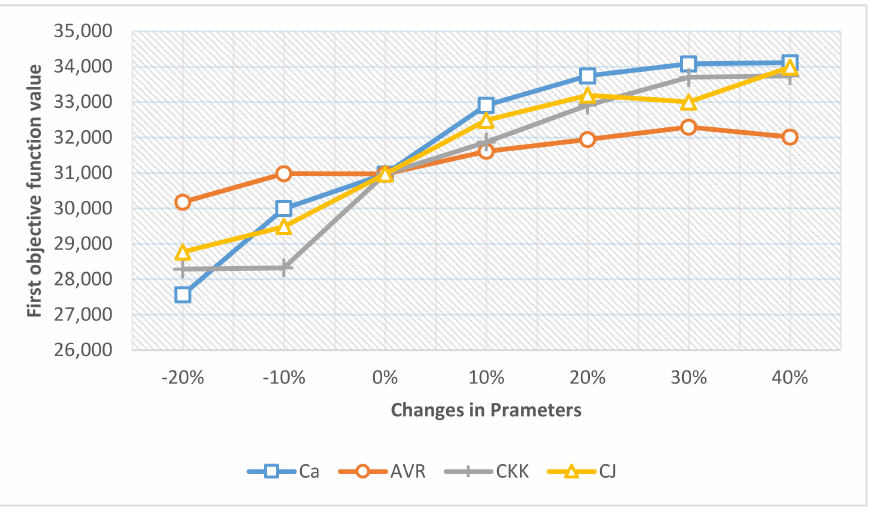
Figure 10. Sensitivity analysis of the first objective function by changing the important